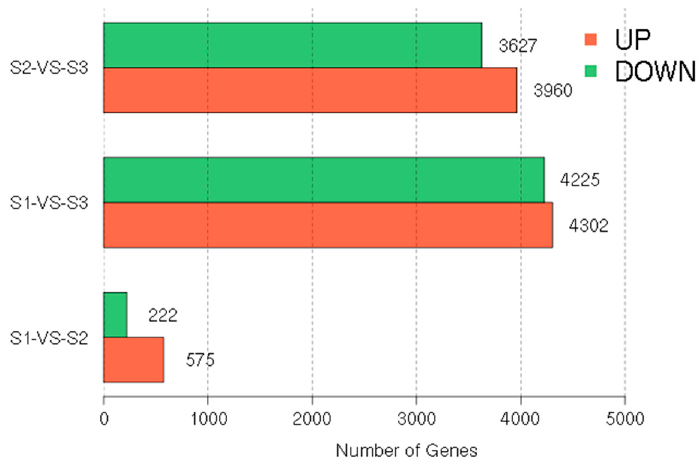
Figure 3. Differential gene expression profiles based on the library of the three leaf stages.